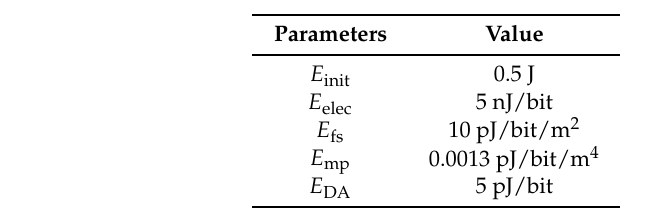
Table 1. Network simulation setup parameters.